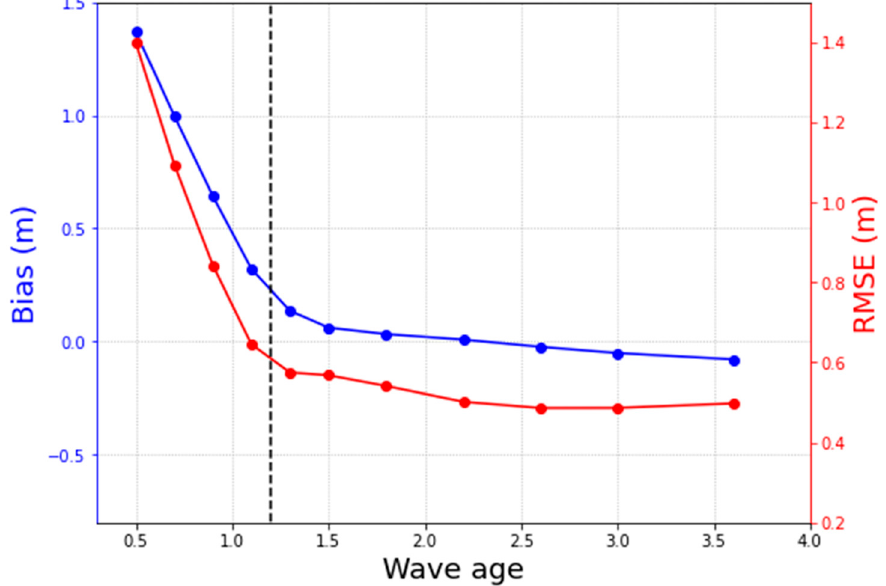
Figure 8. Performances of the deep learning derived ASCAT SWH against WW3 hindcast with respect to wave age. Blue and red symbols represent bias and RMSE, dashed line is for wave age = 1.2.